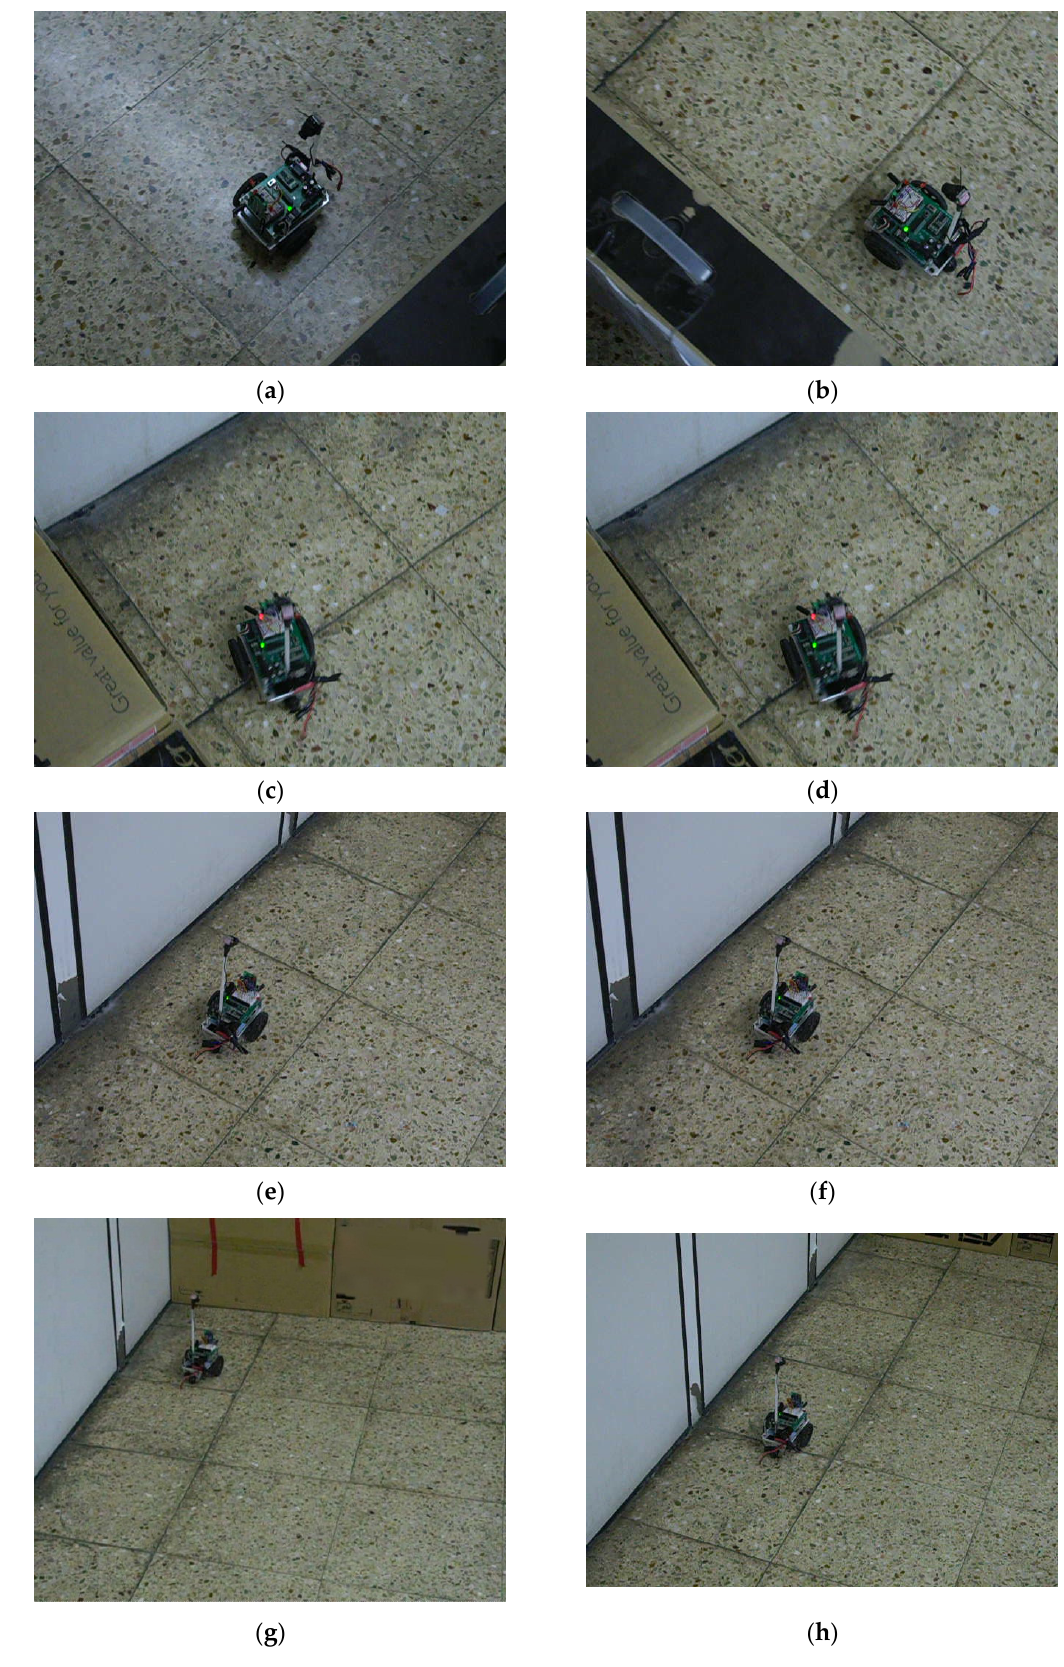
Figure 26. Wall ‐ following patrol. ( a ) Initial position; ( b ) Wall ‐ following patrol 1 position; ( c ) Patrol 2 position; ( d ) Patrol 3 position; ( e ) Patrol 4 position; ( f ) Patrol 5 position; ( g ) Patrol 6 position; ( h ) Ending position.